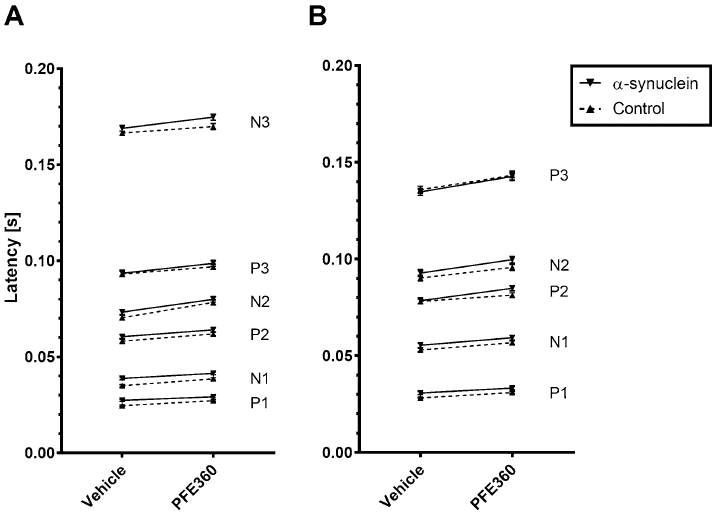
Figure 4. PFE360 causes an increase in the latency of VEP waveforms. All peaks are stacked to show the increase VEP latency. ( A ) Latency of each peak from the VEP recorded in the VC after administration of either vehicle or PFE360. There was significant increase in latency for all peaks except the P4 in both groups. The P4 peak from the VC was excluded as there was a statistically significant interaction of PFE360, wavelength, and group. ( B ) Latency of each peak from the VEP recorded from the SC after administration of either vehicle or PFE360. There was a statistically significant increase in latency for all peaks. Mean ± SEM, all differences between vehicle and PFE360 condition were significant with p values < 0.001 (see Table S1).